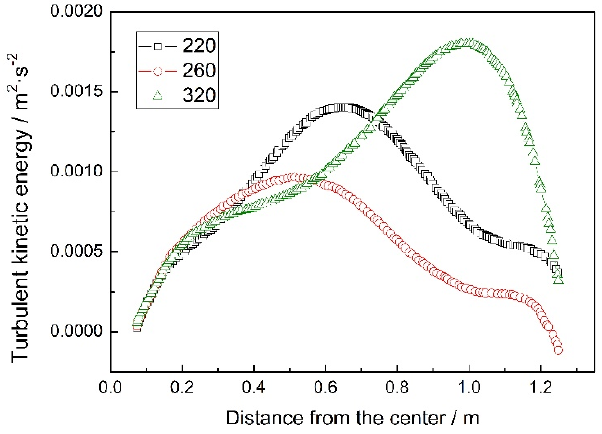
Figure 11. The influence of slab thickness on the turbulent kinetic energy.